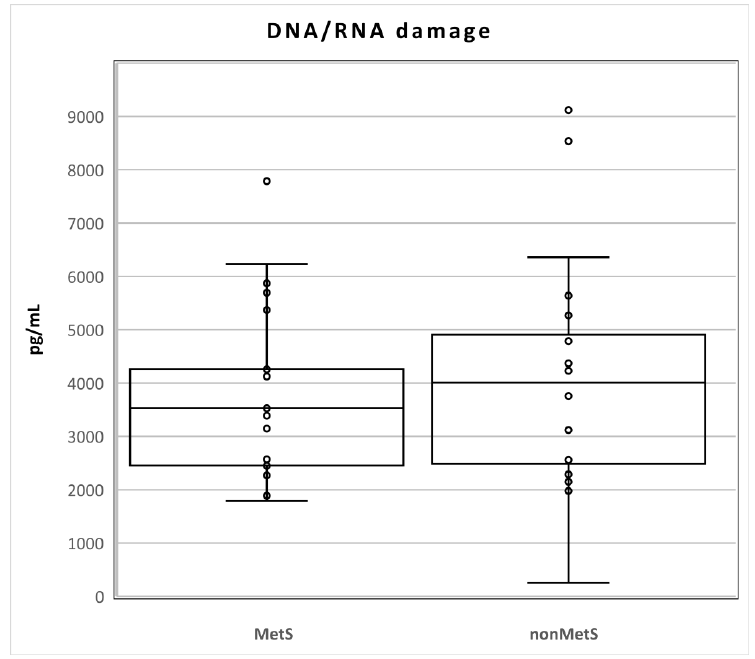
Figure 1. Levels of DNA/RNA damage in MetS and nonMetS patients. Legend: The horizontal line in the boxes indicates the position of the median, the ends of the boxes define the 25th and 75th percentiles, and error bars mark the 10th and 90th percentiles. Y is an outlier.